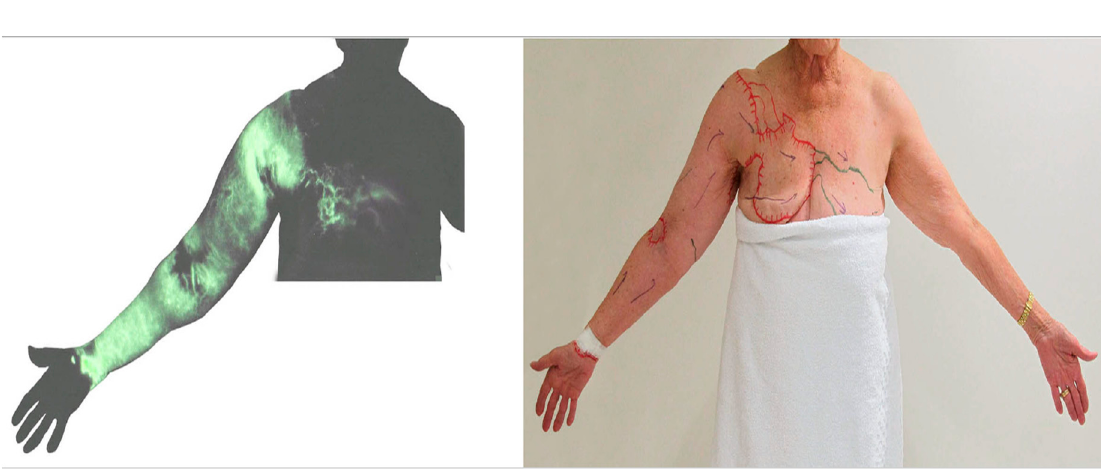
Figure 9. ICG lymphography image (left) and tracing photo (right) in a patient with breast cancer-related lymphoedema. Dermal backflow in the right arm extended to the right front chest and then connected to the left axillary lymph node via the superficial lymph-collecting vessels in the left chest. (Reproduced from [17] with permission).